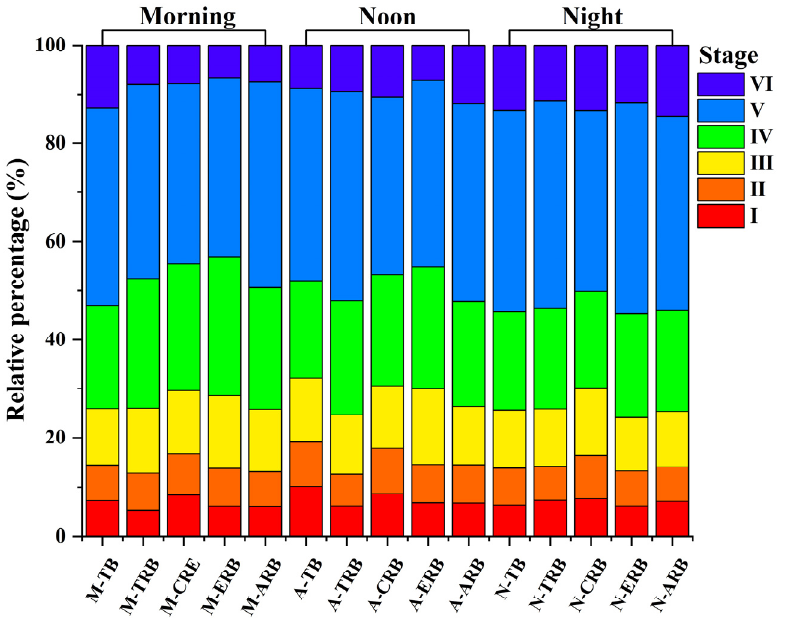
Figure 4. Diurnal variation in particle size distribution of the culturable bacteria and the four antibiotic-resistant bacteria.